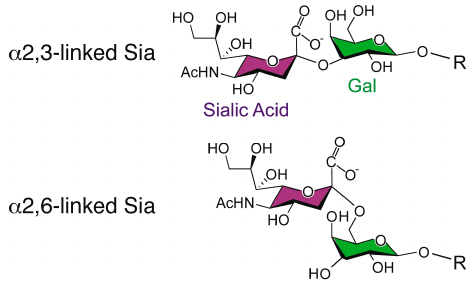
Figure 1. The structure of N -acetylneuraminic acid, a type of sialic acid, in both linkage conformations. The HA spike protein is a membrane-anchored homotrimer composed of a fibrous stalk region, and a globular head containing a sialic acid binding pocket at the membrane-distal tip of each monomer (Figure 2). The binding site is characterized by four structural features, the 190- α helix, the 130-loop, the 220-loop, and a hydrogen-bonded network of conserved amino acids at positions 98, 153, 183, and 195 that constitute the base of the site [45,46]. The 130-loop contains residues 135, 136, and 137, which form main chain interactions with the sialic acid moiety of the receptor. The 220-loop contains residues for which mutations have been implicated in host specificity due to subtle changes in the architecture of the site that alter the interactions with different conformations associated with the glycosidic linkage type [39,47,48]. For example, human H2 and H3 strains containing leucine at position 226 display preferential binding to α 2,6-linked Sia, whereas avian strains containing glutamine at this position favor α 2,3-linked Sia. In these examples, the L226 widens the site changing the hydrogen bond network that would make contacts with the sialic acid whereas the Q226 does not [31,39,49]. The 190-helix also contains residues that have been implicated in determining specificity. Residues 190 and 193 have been shown to have importance for group 1 viruses, namely H1 and H5 strains [37,38,50,51], and changes at position 190 are sometimes accompanied by changes at position 225 as determinants of specificity. A number of other amino acid residues including but not limited to 189, 193, 194, 216, 198, 211, and 222 may influence the architecture of the region and have also been shown to be important for binding and specificity [38,52–54].